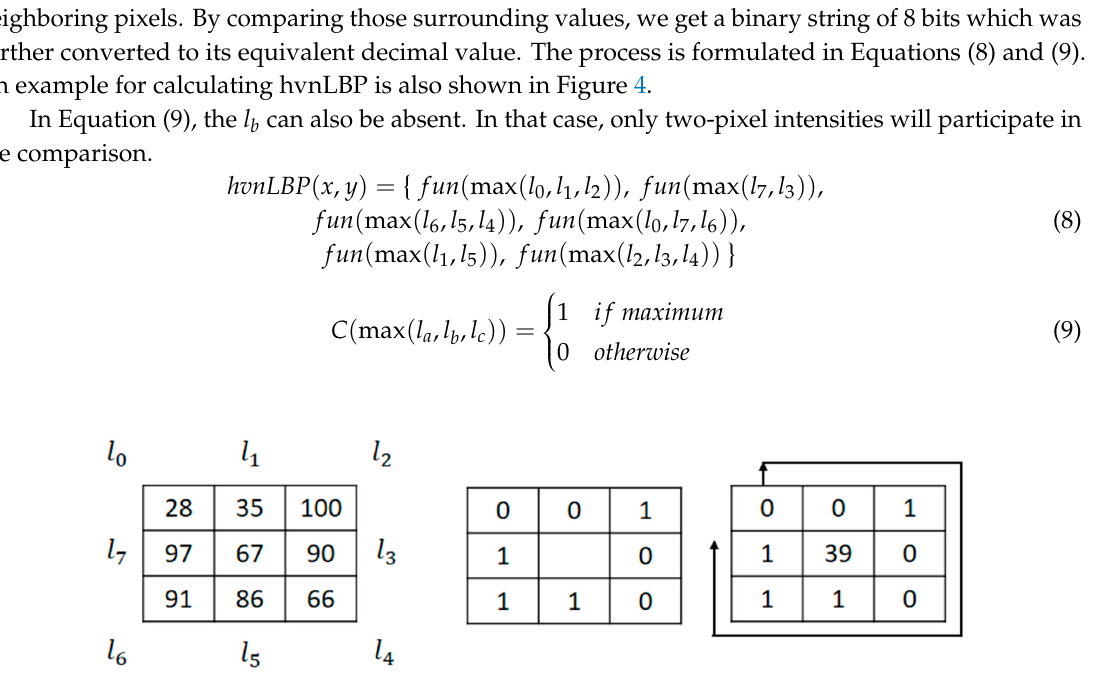
Figure 4. Calculation of horizontal–vertical neighborhood local binary pattern (hvnLBP) feature